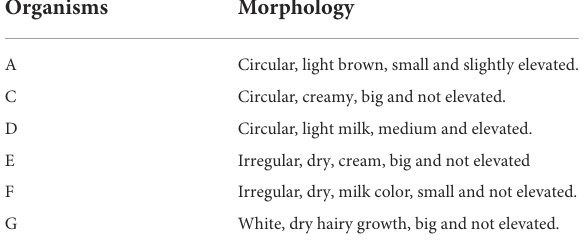
TABLE 1b Morphological characteristics of microorganisms. Organisms Morphology